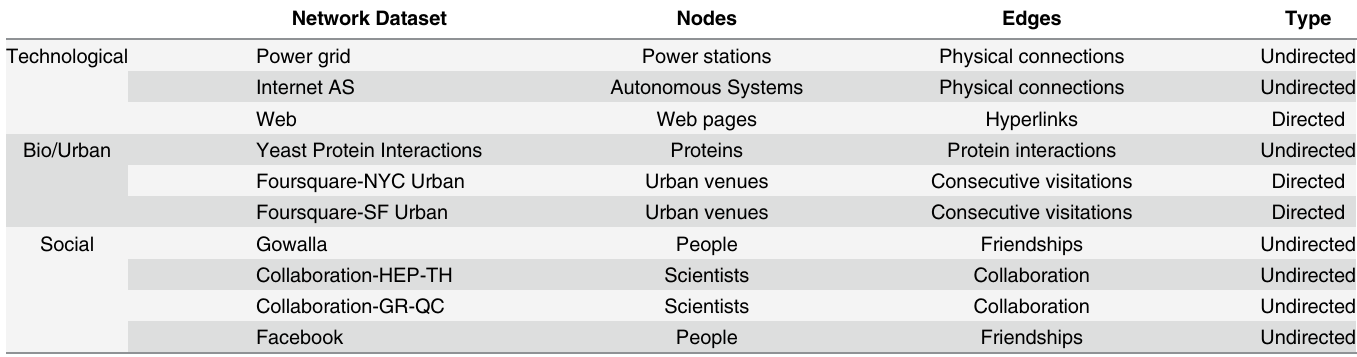
Table 1. Network dataset meta-information. Basic information about the relationships that the real network datasets used for our power-hop analysis rep- resent. For every network we define its nodes and edges, as well as its type (i.e., directed vs undirected). For the collaboration networks, HEP-TH captures the collaborations between high energy theoretical physicist, while the GR-QC captures the collaborations between physicist working on general relativity and quantum cosmology. Furthermore, the urban networks capture consecutive visitations by Foursquare users to venues in New York City and San Fran- cisco respectively.